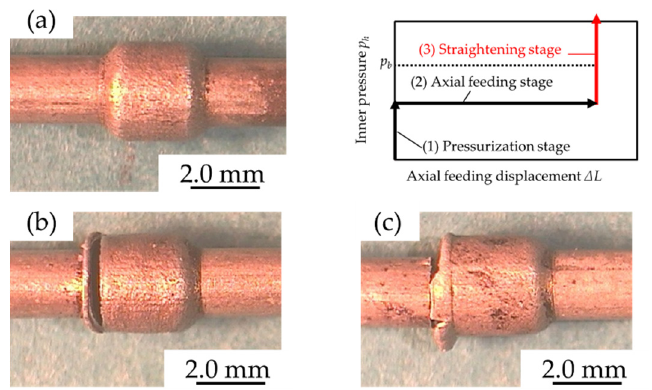
Figure 25. Forming limit of the small ZM21 tube in the cylinder-shape warm THF at 250 °C: ( a ) no fracture ( α = 200%); ( b ) fracture ( α = 230%); ( c ) fracture ( α = 250%).